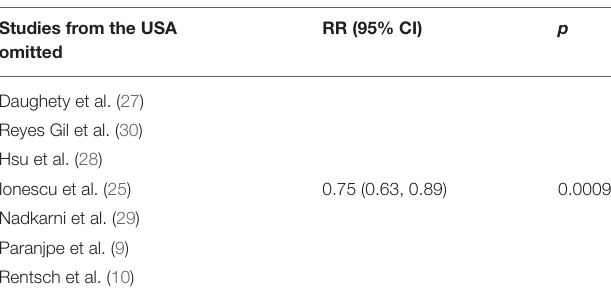
TABLE 6 | Sensitivity analysis by omitting studies from USA in random-effects